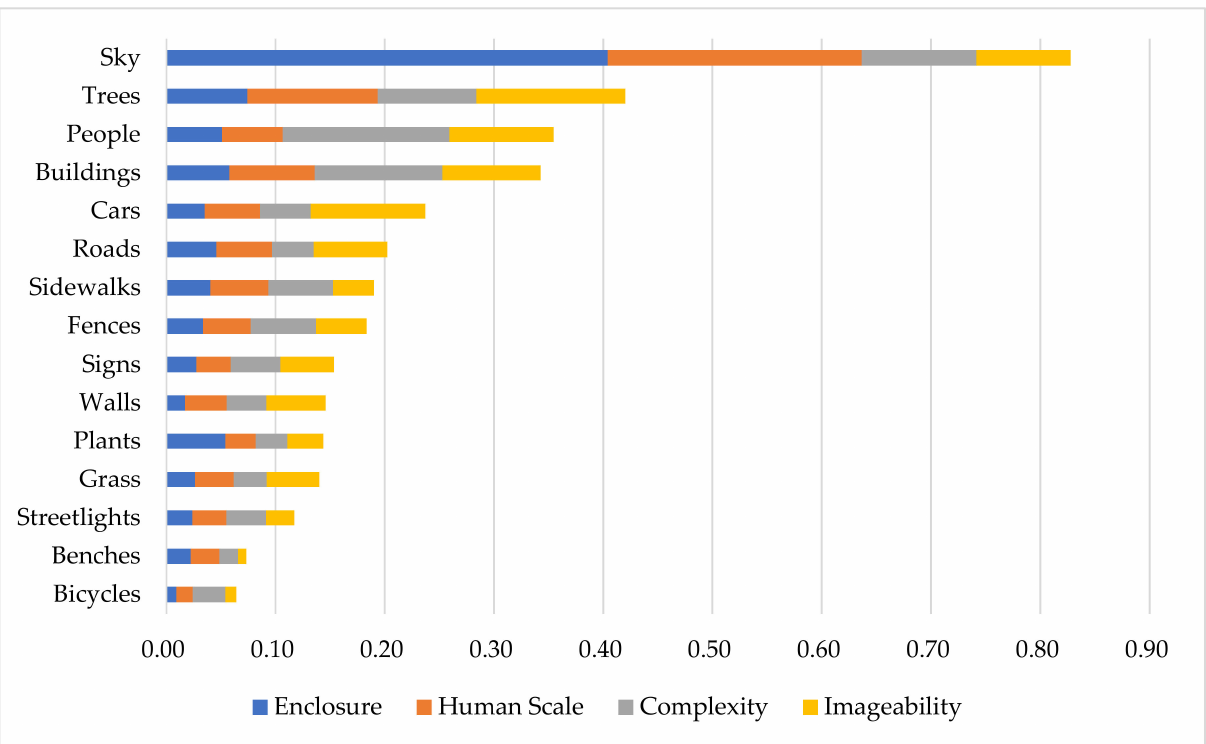
Figure 5. Top 15 important features in predicting four subjective